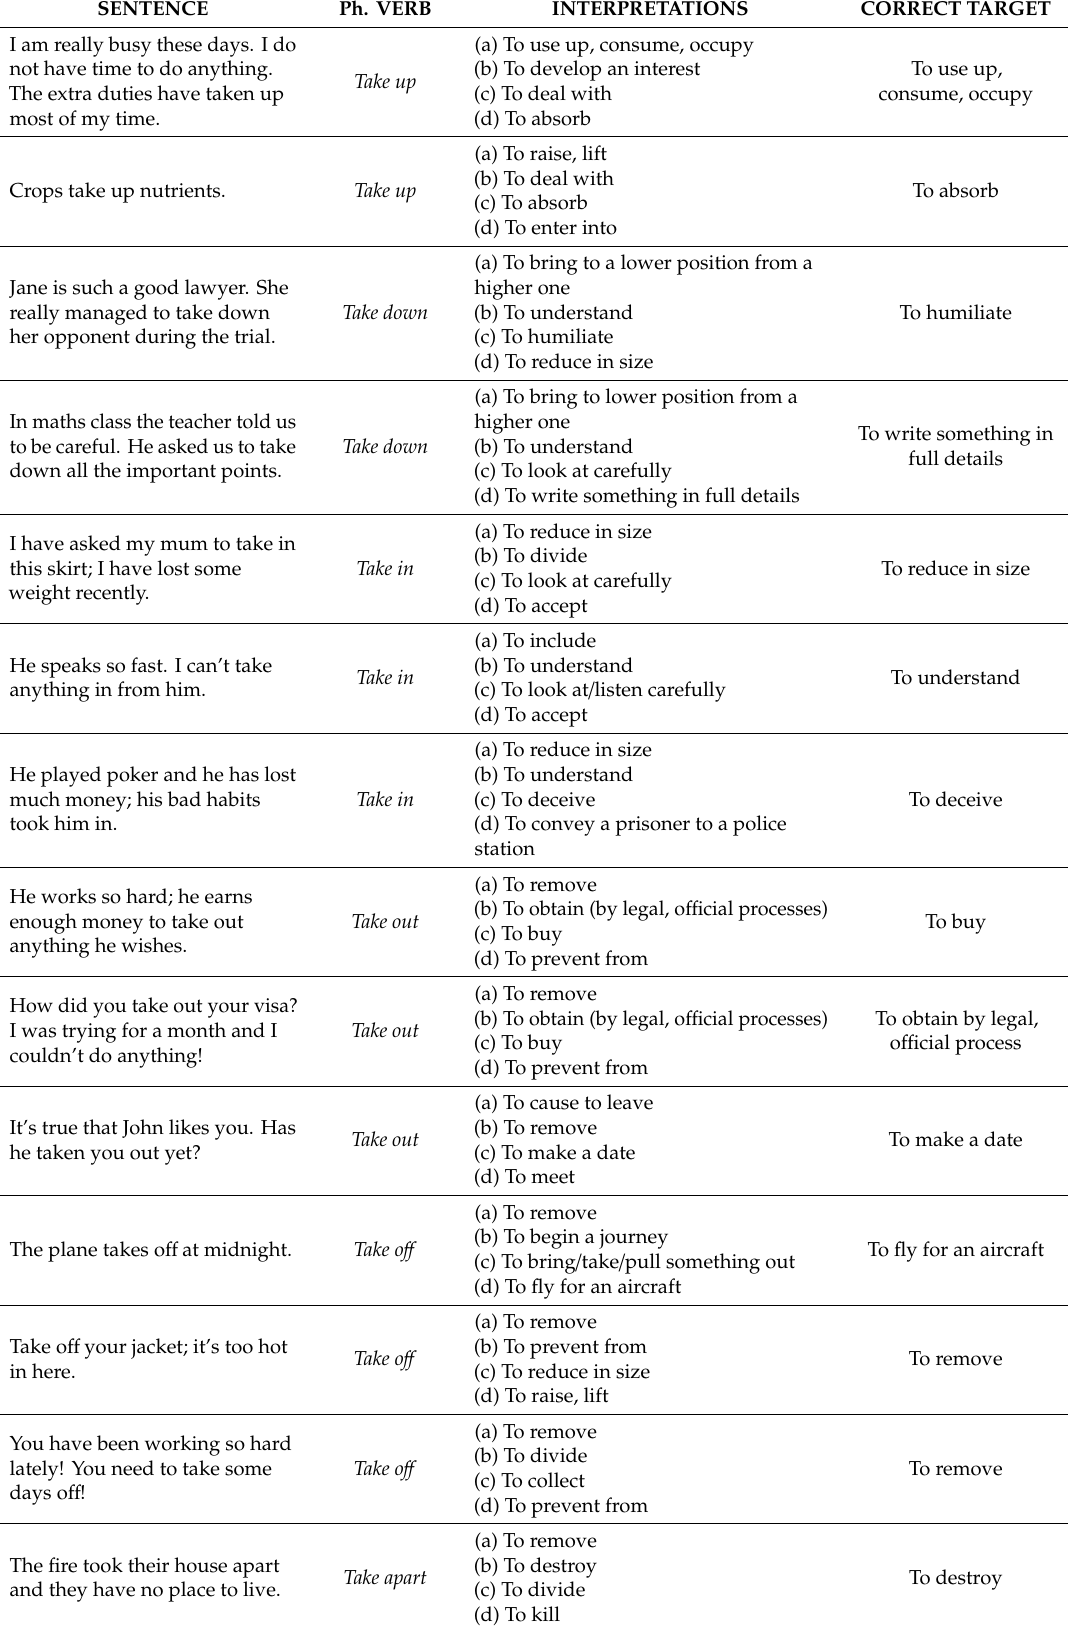
Table 1. Instances of English phrasal verbs used in task 1 along with their possible interpretations. SENTENCE Ph. VERB INTERPRETATIONS CORRECT